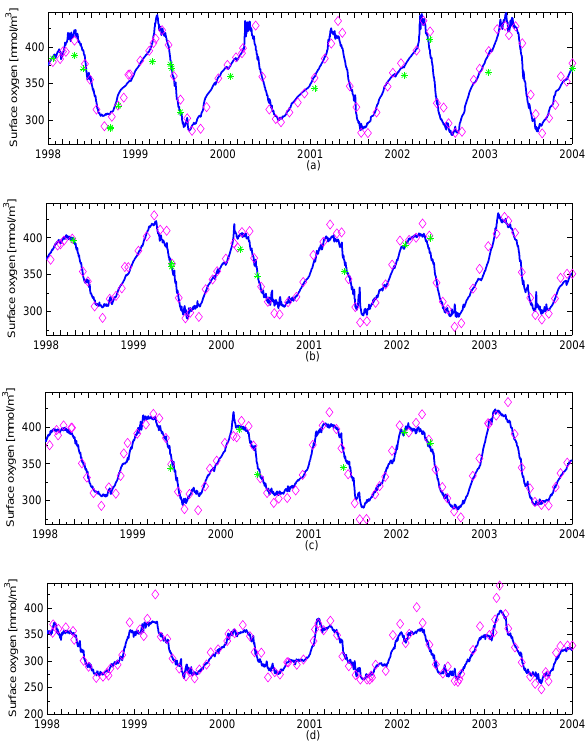
Fig. 8. Simulated six year time series of surface oxygen. Calculated results are presented with a thick solid line, FIMR data with aster- isks, and BED data with diamonds: (a) – at GS; (b) – at BS; (c) – at AS; (d) – at FS.